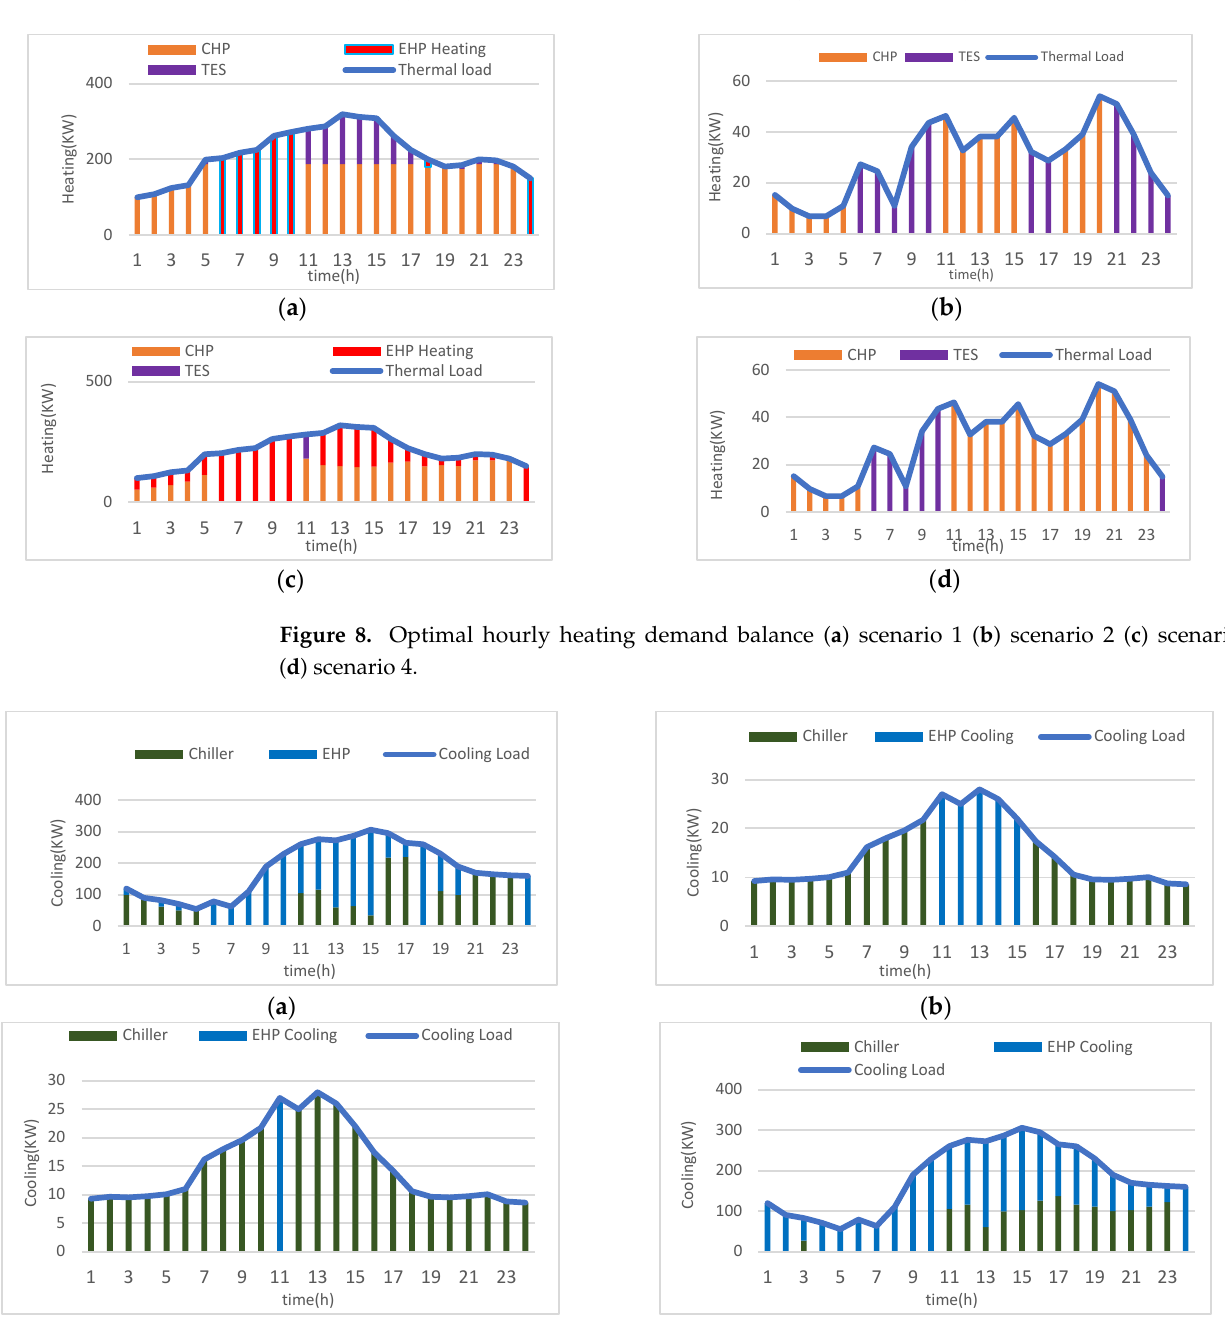
Figure 7. Optimal hourly DC-electrical demand balance ( a ) scenario 1 ( b ) scenario 2 ( c ) scenario 3